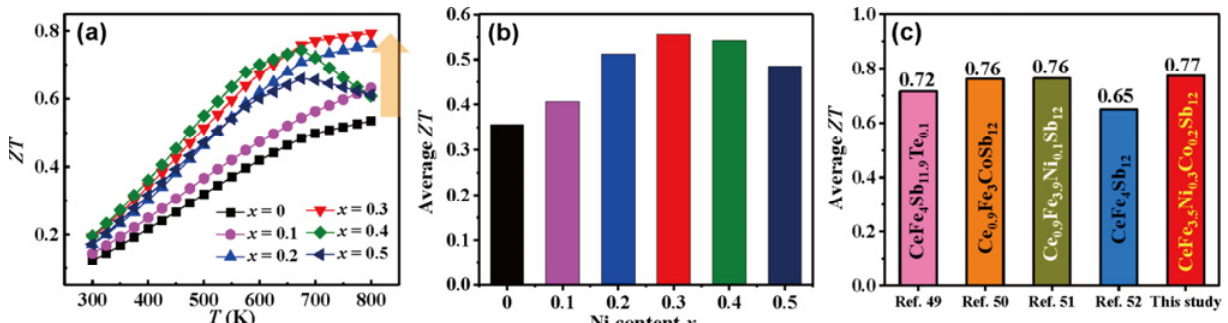
Fig. 10 (a) ZT values and (b) average ZT of CeFe 3.8 − x Ni x Co 0.2 Sb 12 at 300–800 K. (c) Comparison of the average ZT (650–800 K) of the optimized CeFe 3.5 Ni 0.3 Co 0.2 Sb 12 in this study and other studies on Ce-filled Fe-based skutterudites